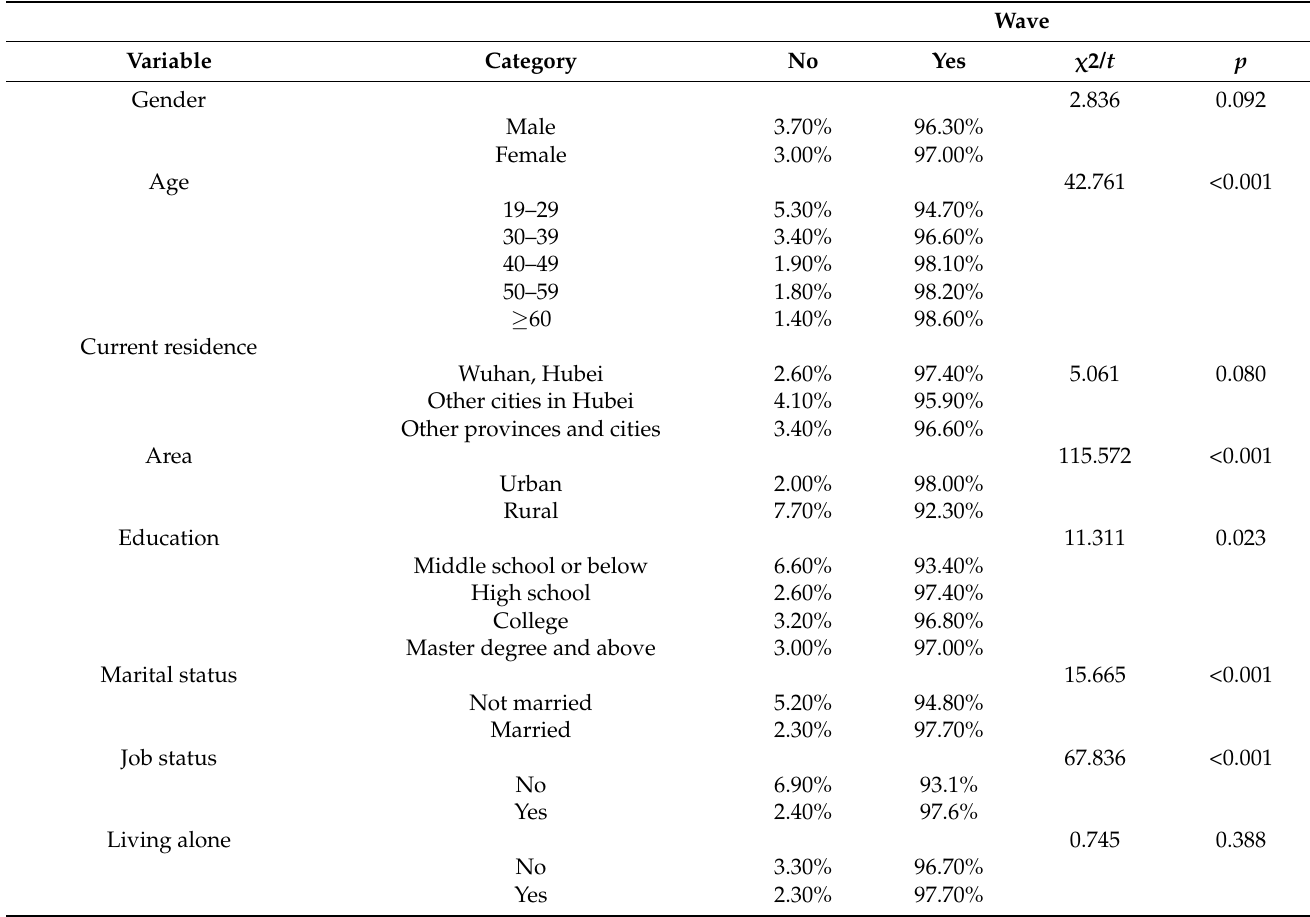
Table 2. Results of single factor analysis of wearing face masks on two surveys.